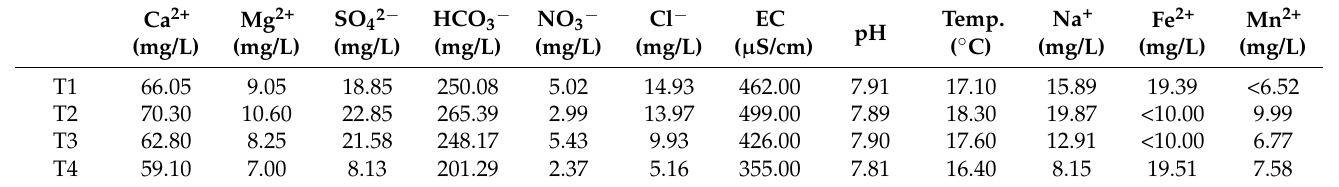
Table 6. Data of the major chemical constituents from the main four drainage canals (October 2019).